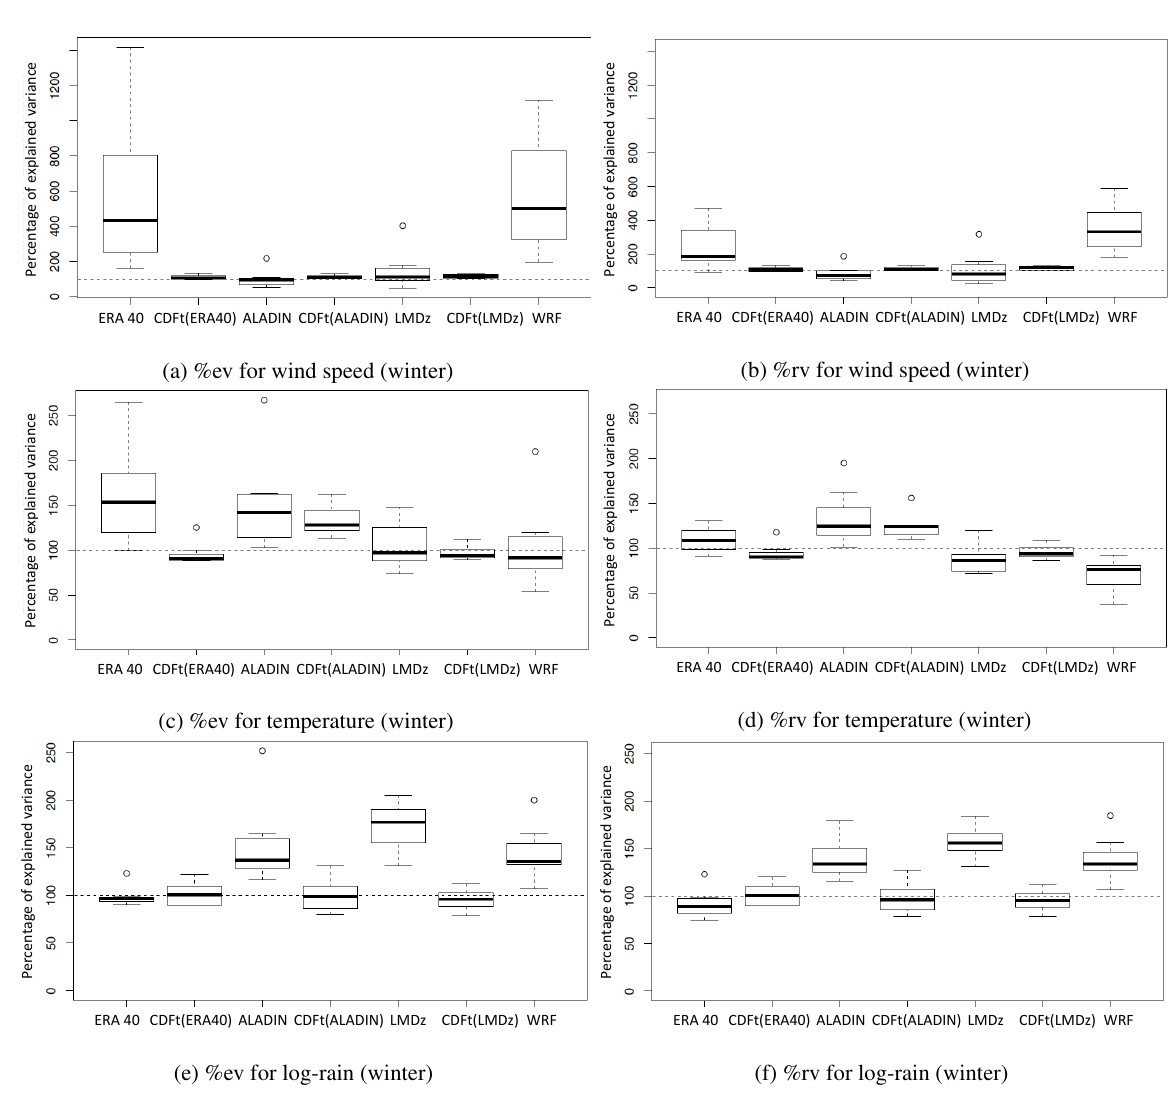
Fig. 3. Boxplots of percentages of explained variance (left column) and ratios (sim/obs) of variances in % (right column) computed over the evaluation period (1996–2000 for wind, and 1991–2000 for temperature and rain) in winter. For rain, the variances are calculated on the Fig. 3: Boxplots of percentages of explained variance (left column) and ratios (sim/obs) of variances in % (right column) Fig. 3: Boxplots of percentages of explained variance (left column) and ratios (sim/obs) of variances in % (right column) log-values of rainfall data (see text for details). The closer to the dashed line at 100%, the better the variability of the simulations. Fig. 3: Boxplots of percentages of explained variance (left column) and ratios (sim/obs) of variances in % (right column) Fig. 3: Boxplots of percentages of explained variance (left column) and ratios (sim/obs) of variances in % (right column) computed over the evaluation period (1996-2000 for wind, and 1991-2000 for temperature and rain) in winter. For rain, the computed over the evaluation period (1996-2000 for wind, and 1991-2000 for temperature and rain) in winter. For rain, the Fig. 3: Boxplots of percentages of explained variance (left column) and ratios (sim/obs) of variances in % (right column) Fig. 3: Boxplots of percentages of explained variance (left column) and ratios (sim/obs) of variances in % (right column) computed over the evaluation period (1996-2000 for wind, and 1991-2000 for temperature and rain) in winter. For rain, the computed over the evaluation period (1996-2000 for wind, and 1991-2000 for temperature and rain) in winter. For rain, the is linearly related to the surface stress (e.g. Drobinski et al., variances are calculated on the log-values of rainfall data (see text for details). The closer to the dashed line at 100%, the better variances are calculated on the log-values of rainfall data (see text for details). The closer to the dashed line at 100%, the better computed over the evaluation period (1996-2000 for wind, and 1991-2000 for temperature and rain) in winter. For rain, the computed over the evaluation period (1996-2000 for wind, and 1991-2000 for temperature and rain) in winter. For rain, the variances are calculated on the log-values of rainfall data (see text for details). The closer to the dashed line at 100%, the better variances are calculated on the log-values of rainfall data (see text for details). The closer to the dashed line at 100%, the better the variability of the simulations. the variability of the simulations. variances are calculated on the log-values of rainfall data (see text for details). The closer to the dashed line at 100%, the better variances are calculated on the log-values of rainfall data (see text for details). The closer to the dashed line at 100%, the better the variability of the simulations. the variability of the simulations. the variability of the simulations. the variability of the simulations. ues of %ev and %rv for WRF. Indeed, WRF produces too Moreover, this generates a high %rv since strong winds in- Moreover, this generates a high %rv since strong winds in- ues of %ev and %rv for WRF. Indeed, WRF produces too Moreover, this generates a high %rv since strong winds in- strong surface winds. This generates high %ev because the duce strong surface stress and wind variance (i.e., in Eq. (7)) strong surface winds. This generates high %ev because the duce strong surface stress and wind variance (i.e., in Eq. (7)) strong surface winds. This generates high %ev because the duce strong surface stress and wind variance (i.e., in Eq. (7)) WRF wind speed mean value is higher than for other RCMs. is linearly related to the surface stress (e.g., Drobinski et al., WRF wind speed mean value is higher than for other RCMs. is linearly related to the surface stress (e.g., Drobinski et al., WRF wind speed mean value is higher than for other RCMs. is linearly related to the surface stress (e.g., Drobinski et al.,